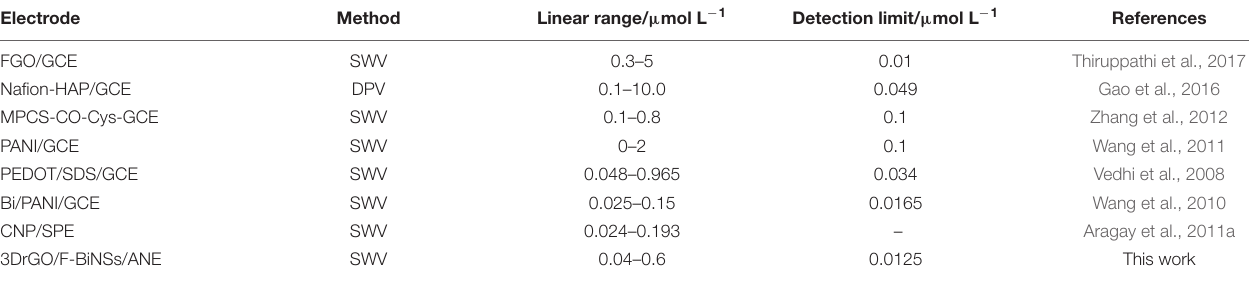
TABLE 1 | Comparison of the 3DrGO/F-BiNSs/ANE with other modified electrodes for the determination of Pb 2 + .